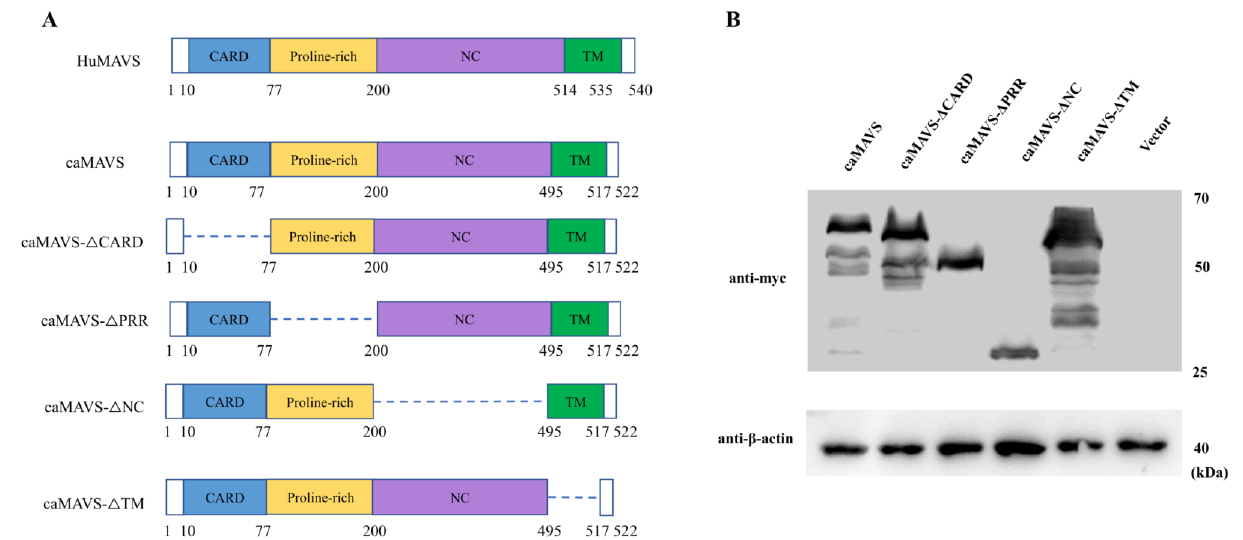
Figure 2. Schematic diagram of caprine MAVS mutants and their expression. ( A ) Schematic representation of caprine MAVS was presented based on the conserved points according to human MAVS. The CARD, PRR, NC and TM domains are represented in blue, yellow, purple, and green, respectively. The schematic representation is also used for constructing truncated mutants. The indicated numbers represent amino acid positions. ( B ) Western blot analysis of the expression of caMAVS and its mutants by transfection with caMAVS and mutant plasmids in HEK-293T cells.